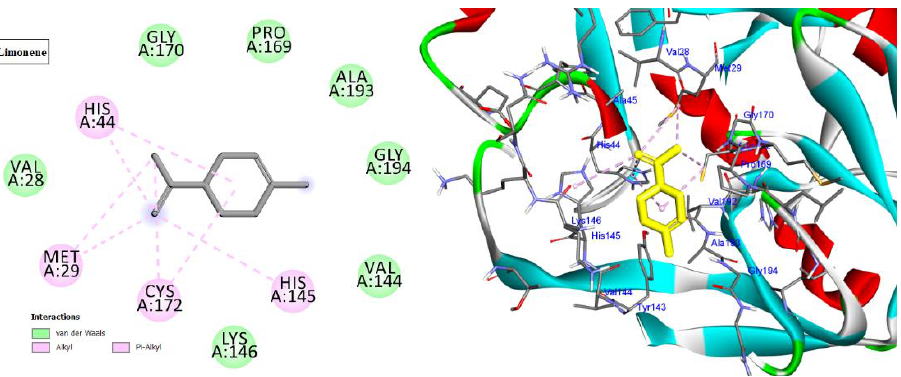
Figure 8. Two-dimensional and three-dimensional images of limonene docked into the HAV 3C protease enzyme binding site.